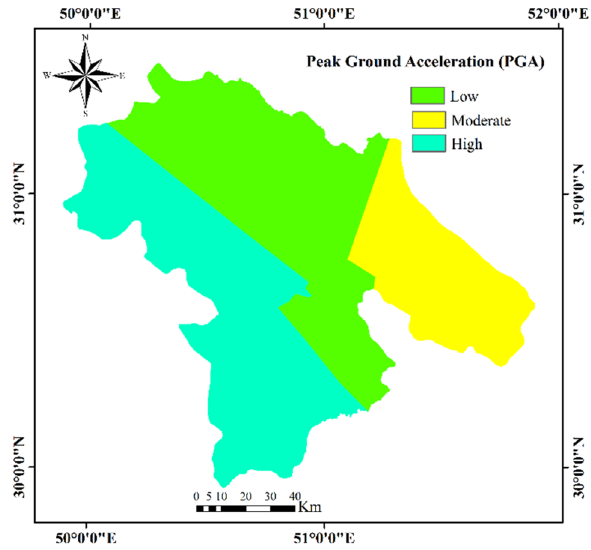
Figure 3. PGA map.